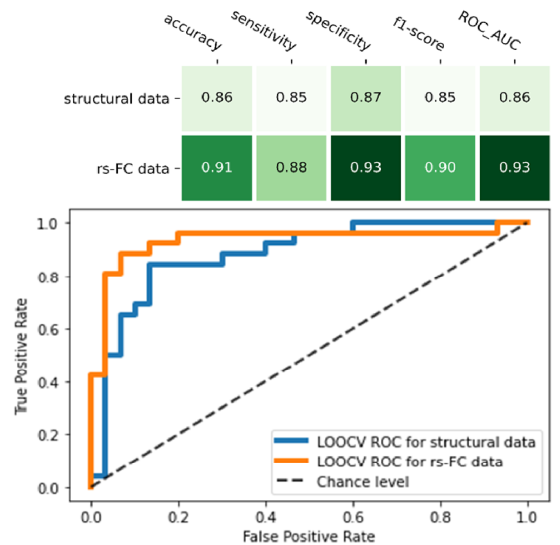
Figure 4. Comparison between two final machine learning models of resting-state functional con- nectivity data and structural data. The figure showed the performance matrix (the upper table) and the receiver operating characteristic (ROC) curve and its area under curve (AUC) score of the two models (the lower chart).